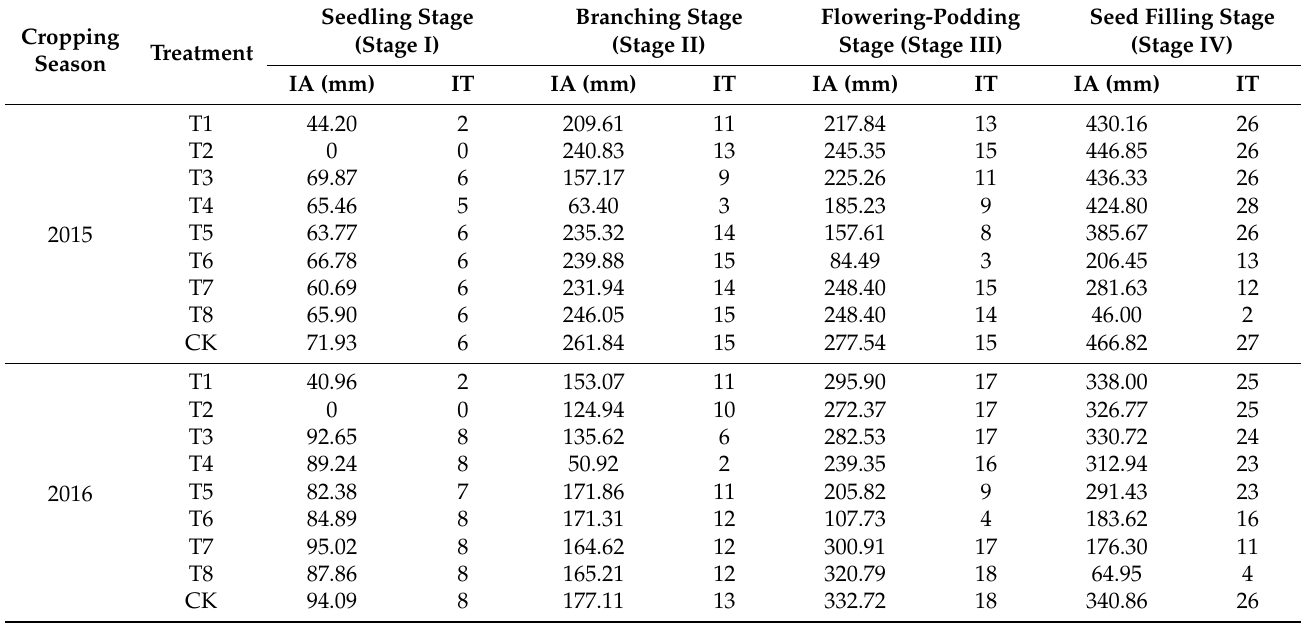
Table 4. Irrigation amount (IA) and irrigation times (IT) at each growth stage of soybean under different treatments in 2015 and 2016 seasons.